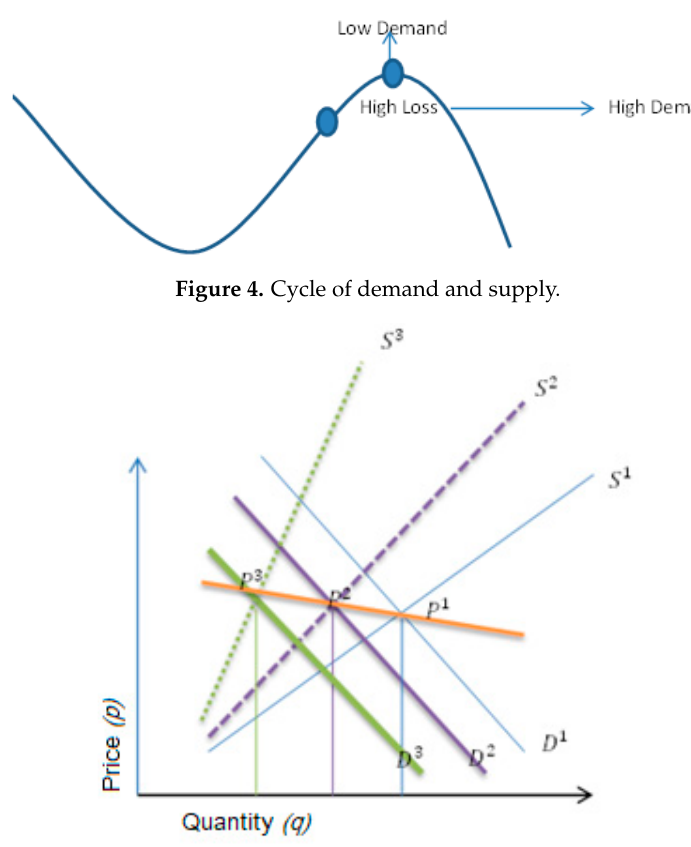
Figure 5. Vicious cycle of market failure.